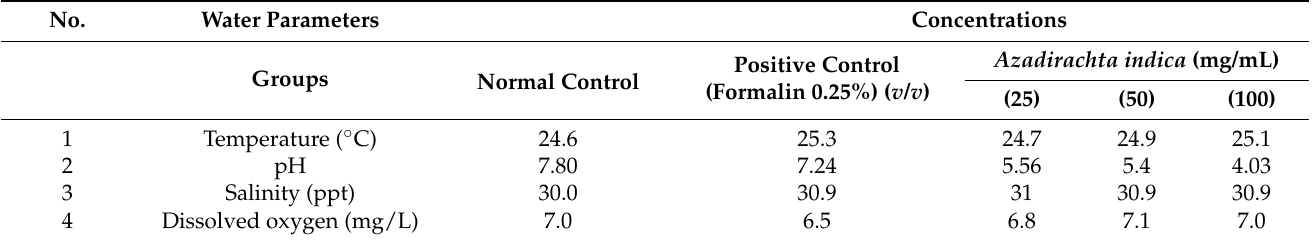
Table 1. Water quality parameters of the solution for the treatment of parasitic leeches.